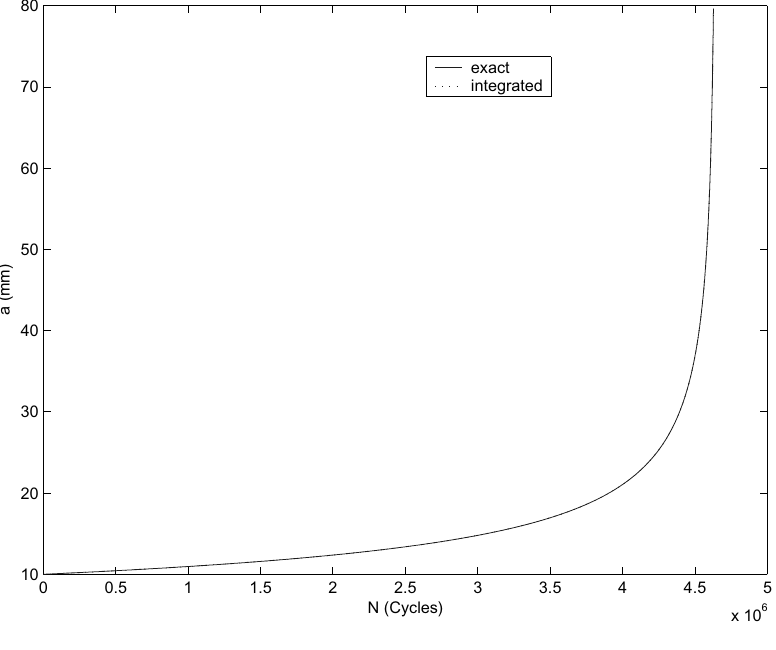
Fig. 2. Comparison between exact and integrated crack growth curves.